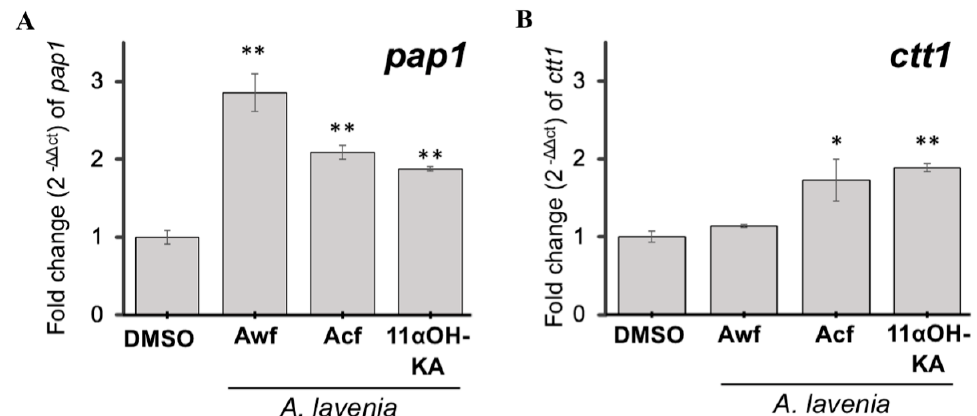
Figure 5. A. lavenia fractions and 11 α OH-KA induced yeast antioxidative stress pathways. The yeast cells were cultured in YES liquid (3% glucose) supplemented with A. lavenia water ( Awf : 1260 µg mL − 1 ), chloroform Acf : (888 µg mL − 1 ) fractions, and 11 α OH-KA (45 µg mL − 1 ) for 18 h. The expression levels of the pap1 + ( A ) and ctt1 + ( B ) genes were measured by quantitative PCR analysis. Values were normalized with those in the DMSO group. Means and S.D. are shown. ( n = 3) *: p < 0.05, **: p < 0.01. 3.7. 11 α OH-KA Upregulates Antioxidant Signaling in Mouse B16F10 Melanoma Cells.